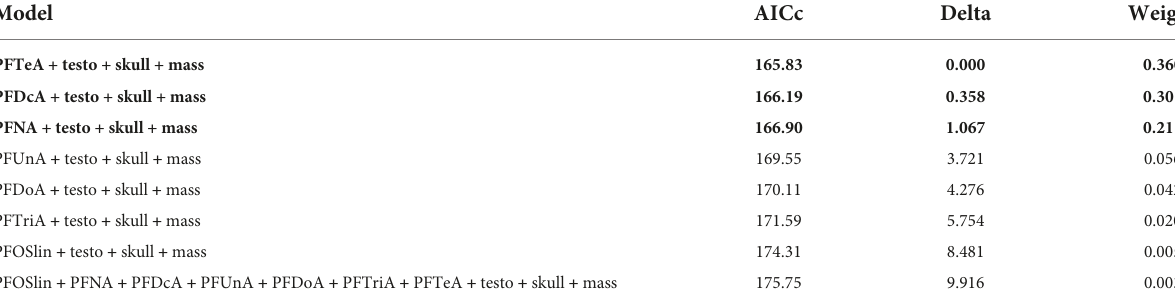
TABLE 4 Rank of lme models for carot1 (plasma carotenoids) as estimated according to Akaike information criterion.